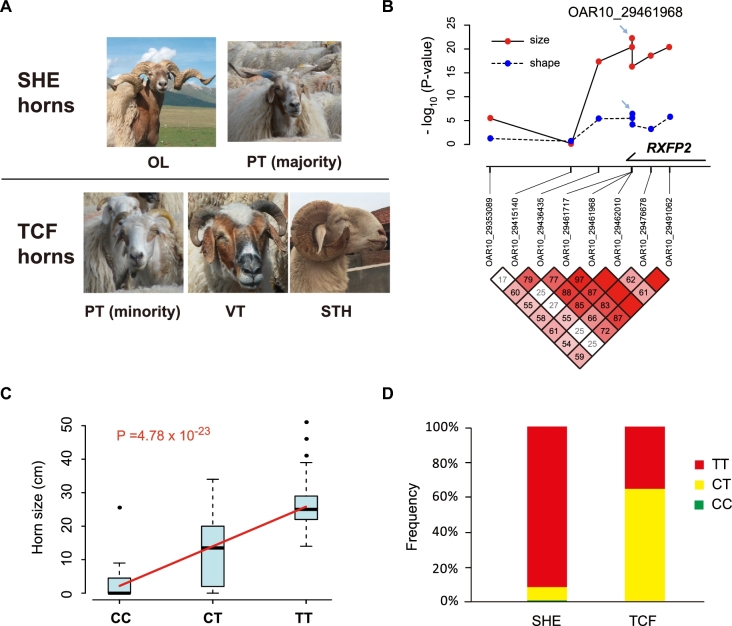

RXFP2 haplotype is correlated with horn shape and size. a) Features of SHE-type and TCF-type horns. b) Association between 8 SNPs and horn phenotypes (size and shape) analyzed in 182 PT sheep. After testing all combinations of genetic models and confounding effects (Supplementary Fig. S12), an additive model (assume A as major allele, a as minor allele, we have code 2 for AA, 1 for Aa, and 0 for aa) was applied for horn size, and a recessive code (1 for AA, 0 for Aa and aa) was applied for horn shape; pair-wise LD between SNP pairs were plotted at the bottom, where numbers represent D΄ statistics. c) Box plot of individual horn sizes among different OAR_29 461 968 genotypes; P value was calculated by linear regression based on additive genetic model, and the fitting line is shown in red. d) Distribution of OAR10_29 461 968 genotypes among PT sheep with different horn shapes.